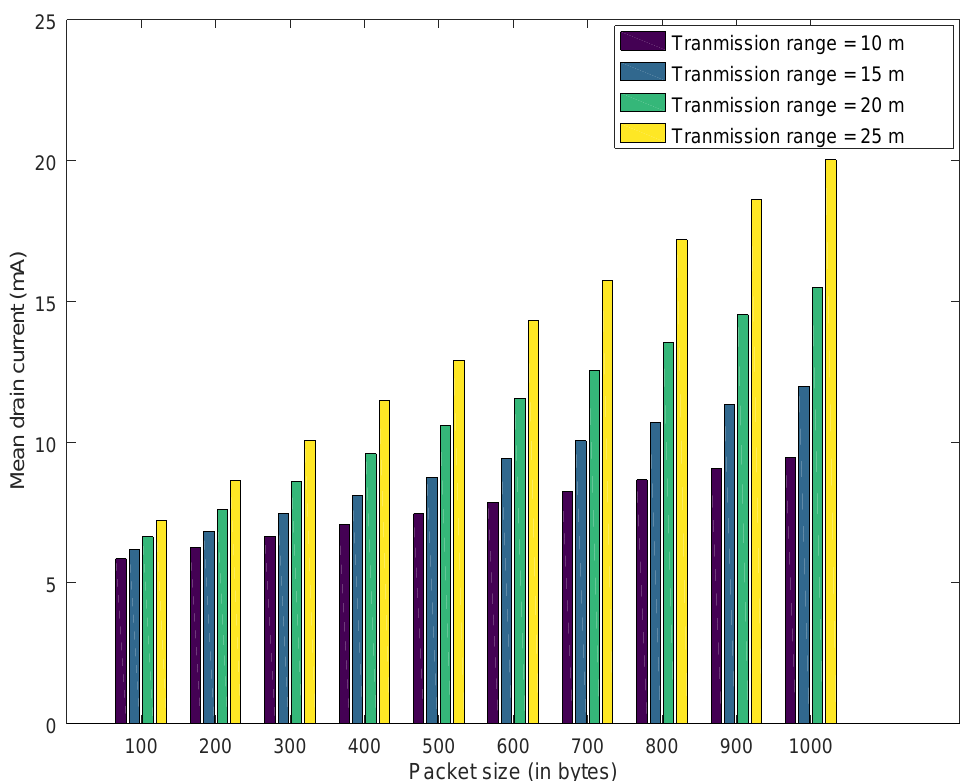
Figure 19. Required Current for the device - Worst